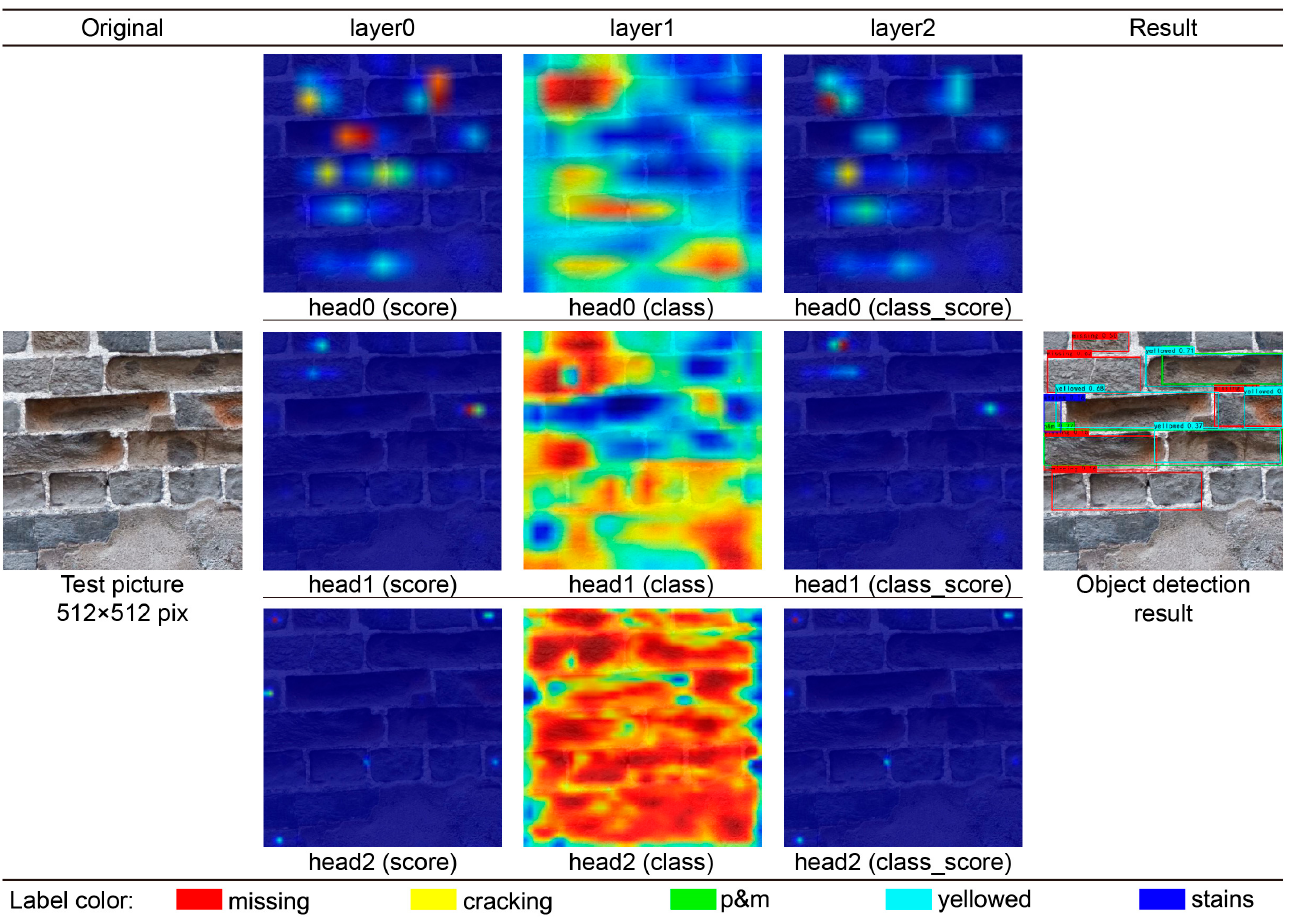
Figure 10. The feature extraction effect of the test image layer in the detection. (Image Source: drawn by the author).